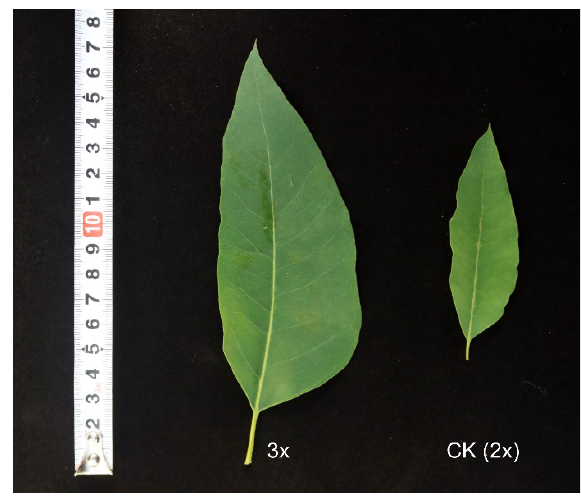
Figure 4. Eucalypts grown in greenhouse at 6 months old. ( a ) Triploid plant. ( b ) Diploid plant.